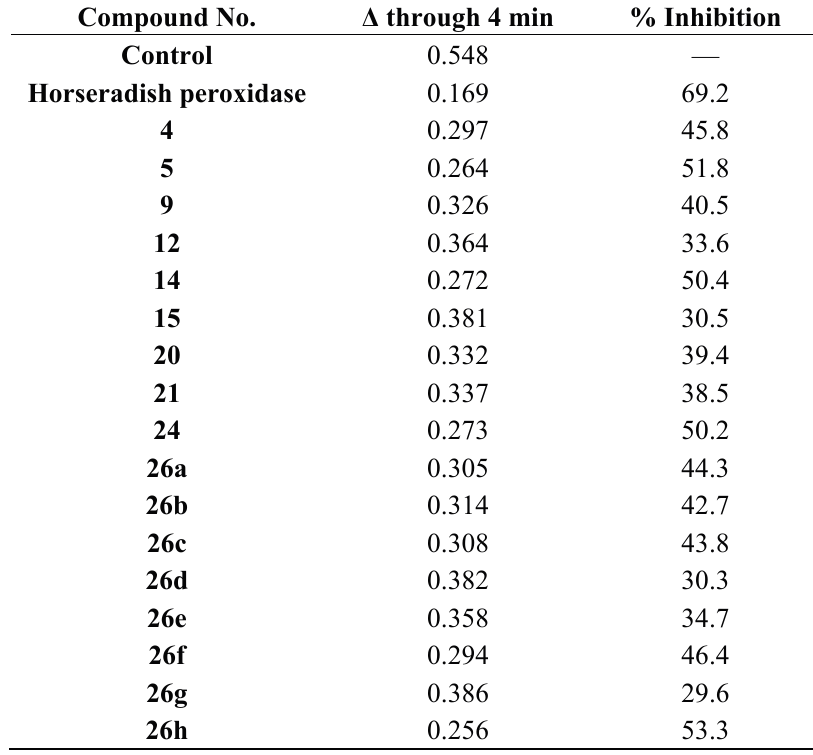
Table 3. Superoxide dismutase mimetic catalytic activity of compounds as antioxidant enzyme. Compound